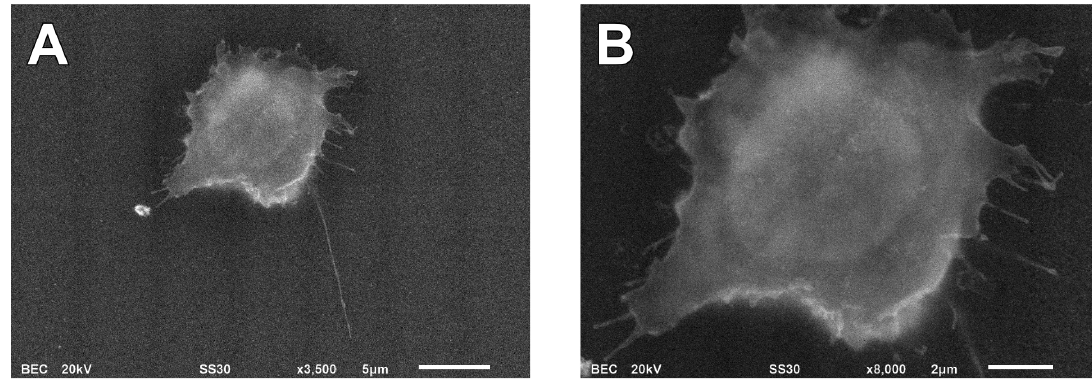
Figure 4. ASEM images by positively charged Nanogold labeling. ( A ) Cells cultured on the ASEM dish were fixed, stained with positively charged Nanogold, and treated with GoldEnhance-EM. 3500× magnification. Scale bar, 5 µm; and ( B ) The cell body was further magnified at 8000× magnification. Scale bar, 2